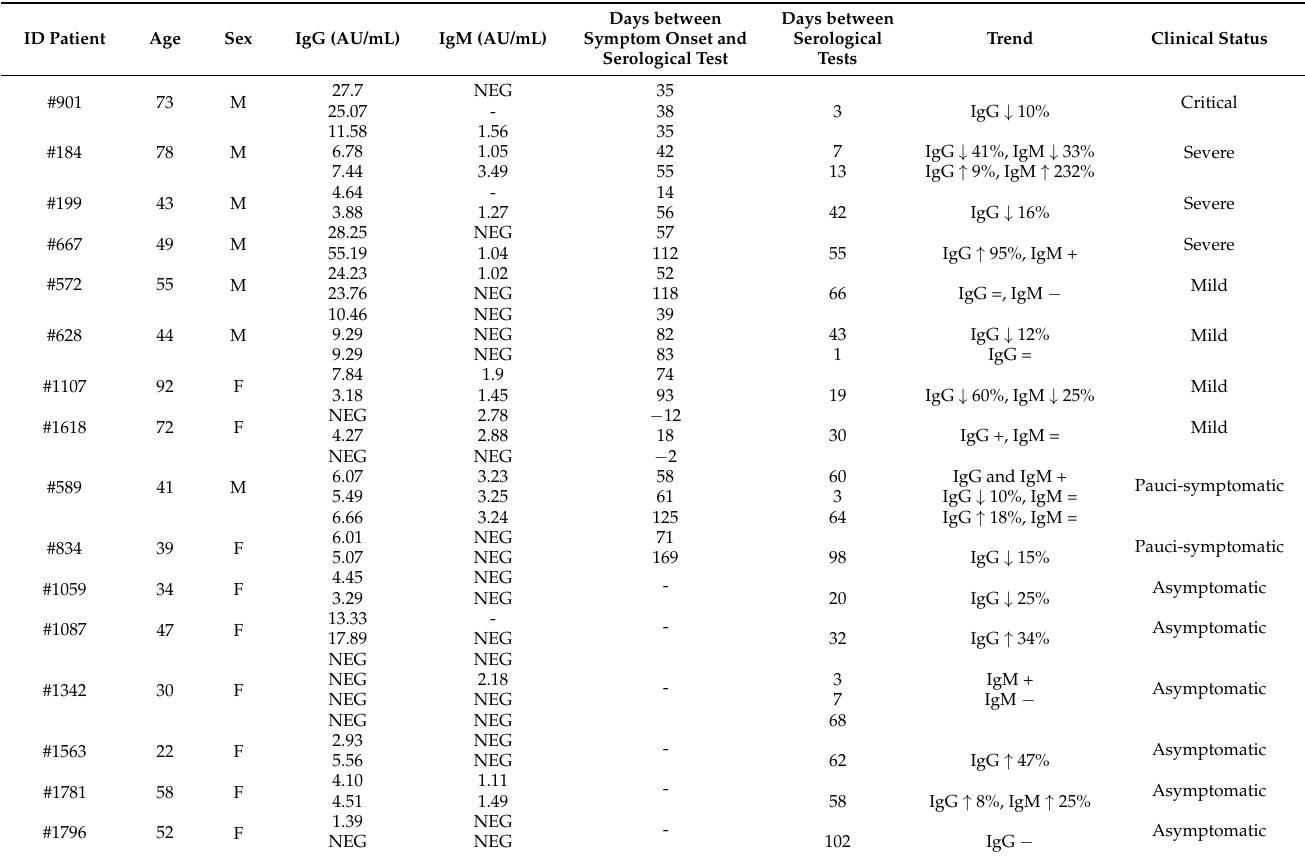
Table 3. Trend of IgG and IgM in COVID-19 patients subjected to multiple serological tests.